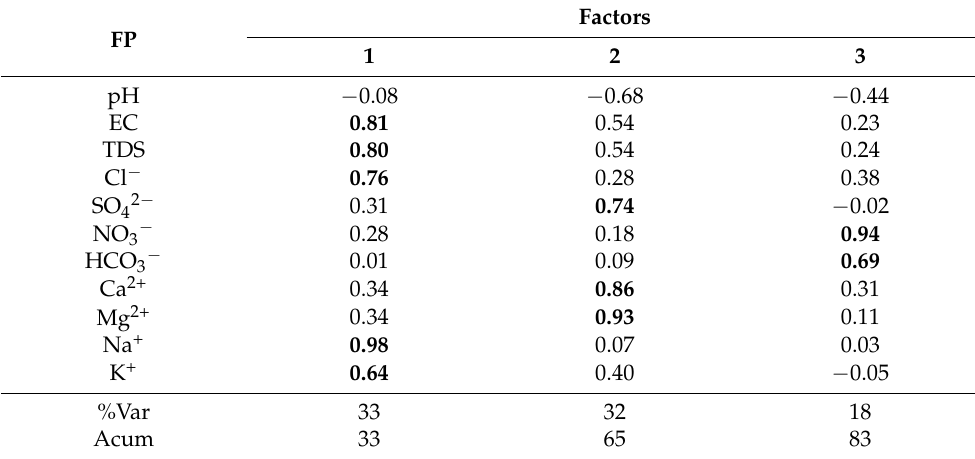
Table 1. Factors using main ions and physical properties.